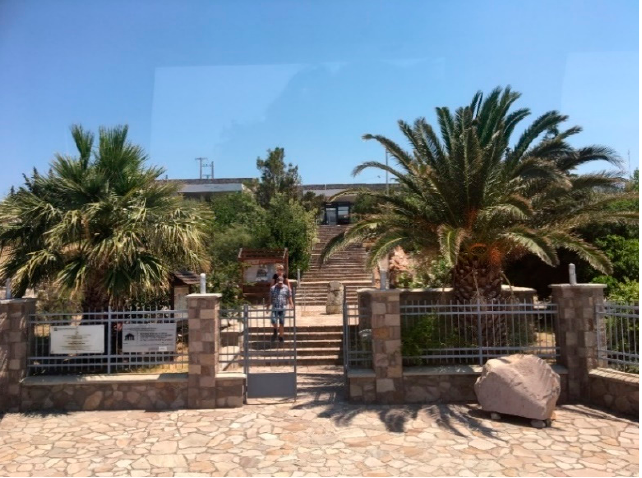
Figure 7. Lesvos Museum entrance in Sigri, close to the Petrified Forest, Greece.